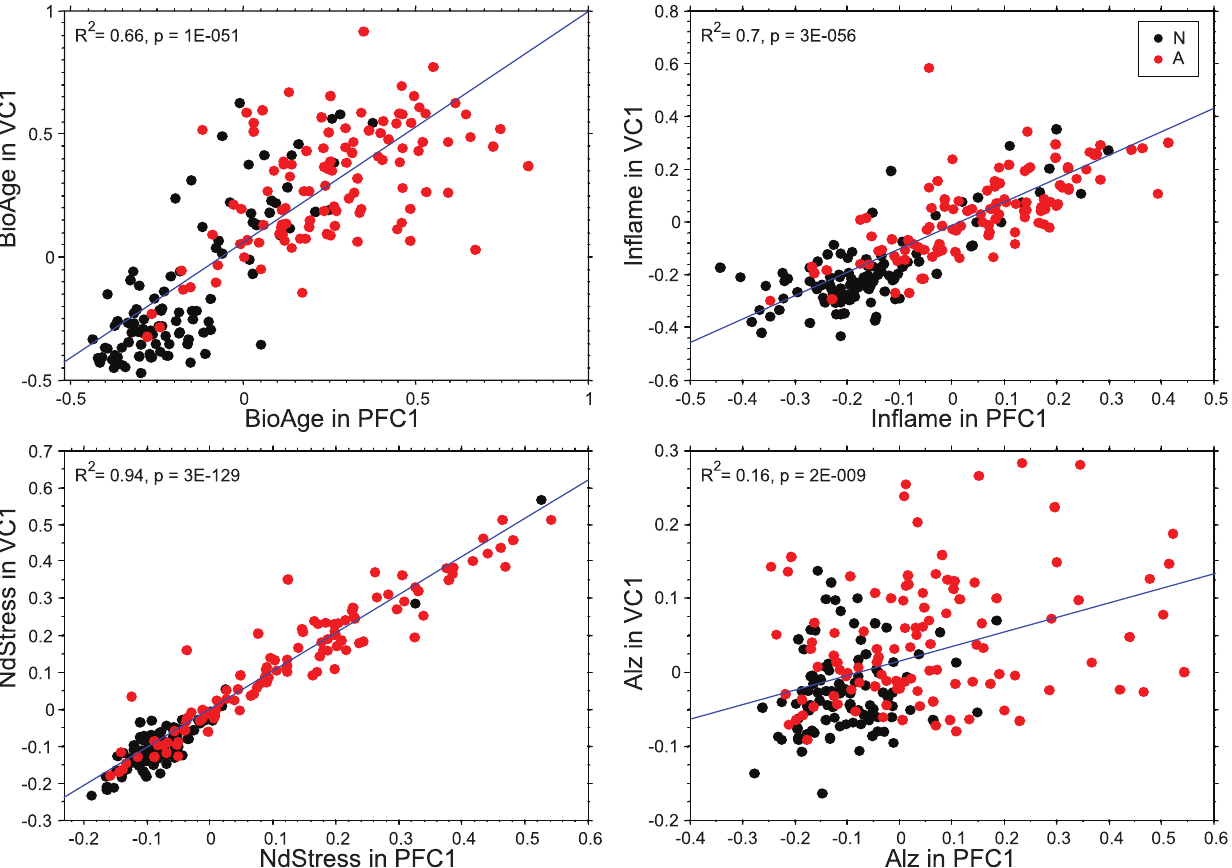
Figure 5. Correlation between biomarker scores in PFC1 and VC1 of the same individuals. Each plot shows relationships between the biomarker values in PFC1 and VC1. Samples from non-demented and AD subjects are shown in black and red respectively.